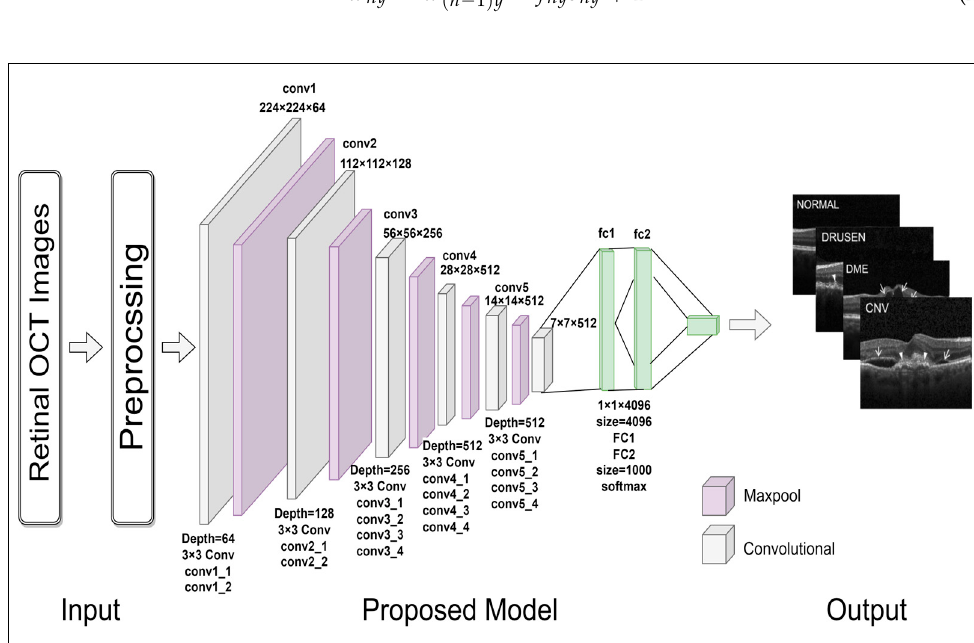
Figure 2. Schematic illustration of proposed work.